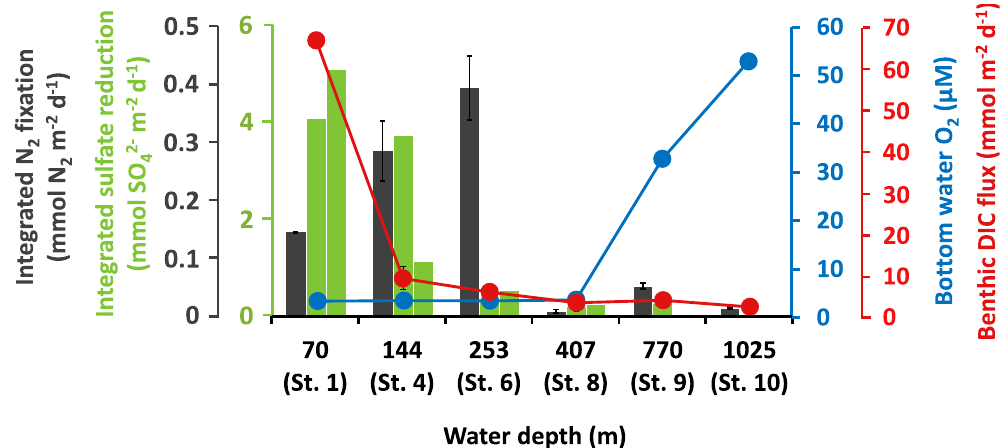
Figure 4. Integrated nitrogen fixation (mmol N 2 m − 2 d − 1 , grey bars, average of three replicates) and integrated sulfate reduction (mmol SO 2 − m − 2 d − 1 , green bars, two replicates) from 0 to 20cm, including dissolved inorganic carbon flux (DIC, mmolm − 2 d − 1 , red curve from 4 Dale et al., 2015) and bottom water O 2 (µM, blue curve) along the depth transect (m). Error bars indicate standard deviation of N 2 fixation.